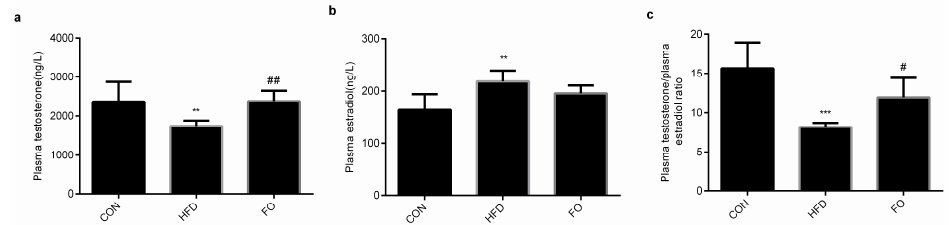
Figure 4. Effects of HFD and FO on plasma testosterone ( a ), estradiol levels ( b ) and the testosterone/estradiol ratio ( c ). Data were expressed as mean ± SD ( n = 10 per group). ** p < 0.01, *** p < 0.001 vs. CON group; # p < 0.05, ## p < 0.01 vs. HFD group.